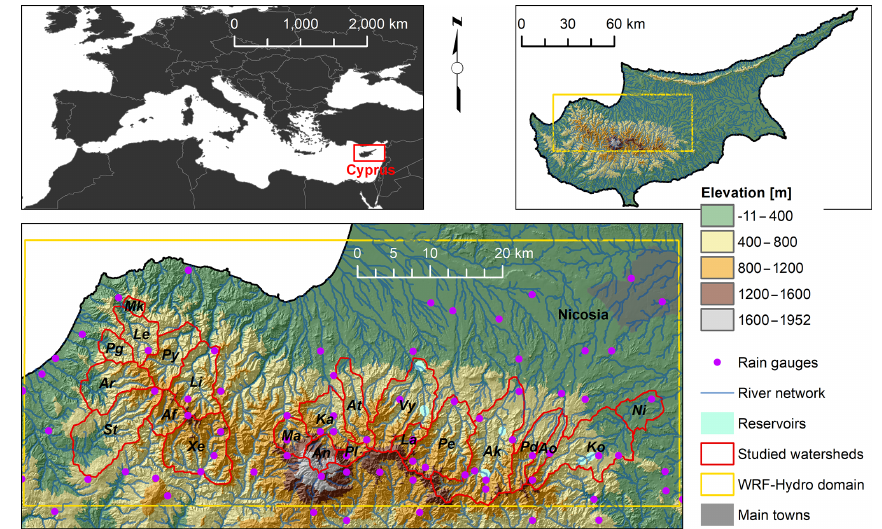
Figure 1. Geographical setting of the island of Cyprus and WRF-Hydro study area with the 22 target watersheds. For watershed abbreviations refer to Table